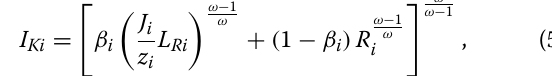
where β is the value share, ω is the elasticity of substitu- tion between L Ri and R i , J represents a positive spillover z from capital variety to labor productivity, and 1 / z is the spillover intensity. We assumed a constant research labor, L Ri , that can be reallocated between